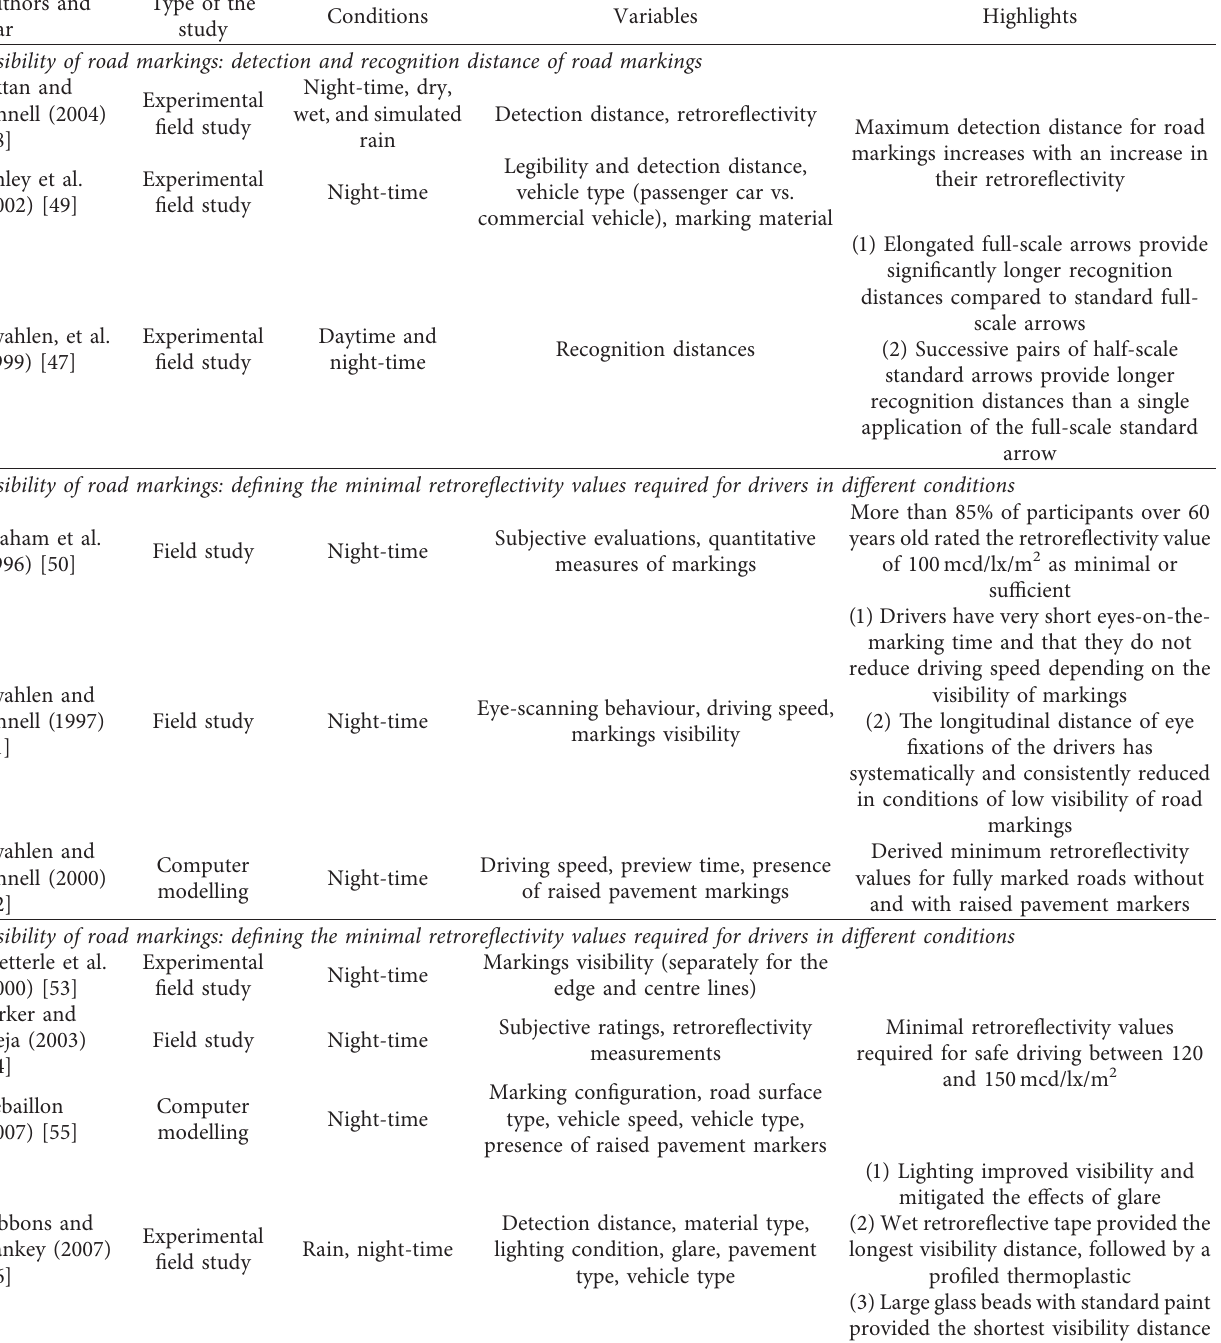
Table 2: The summary of the studies related to the impact of road markings on road safety.